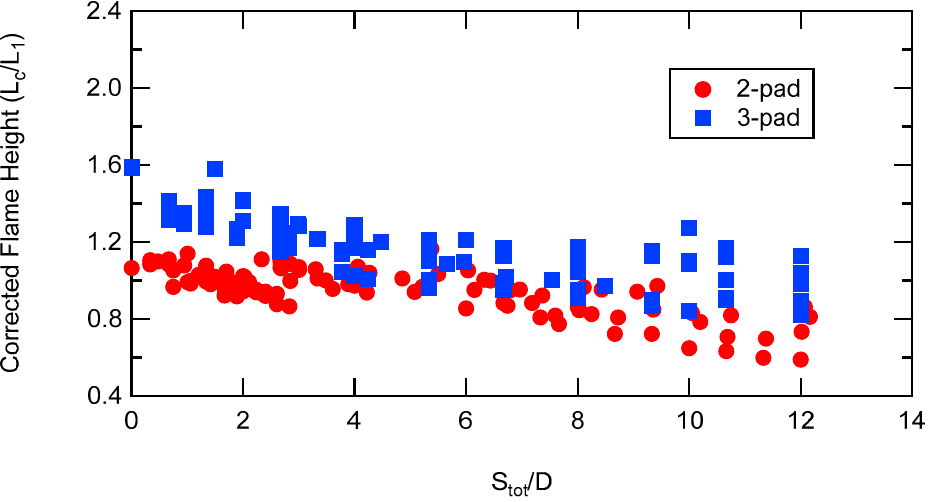
Figure 6. Corrected two-pad and three-pad flame heights as a function of total normalized pad separation distance.